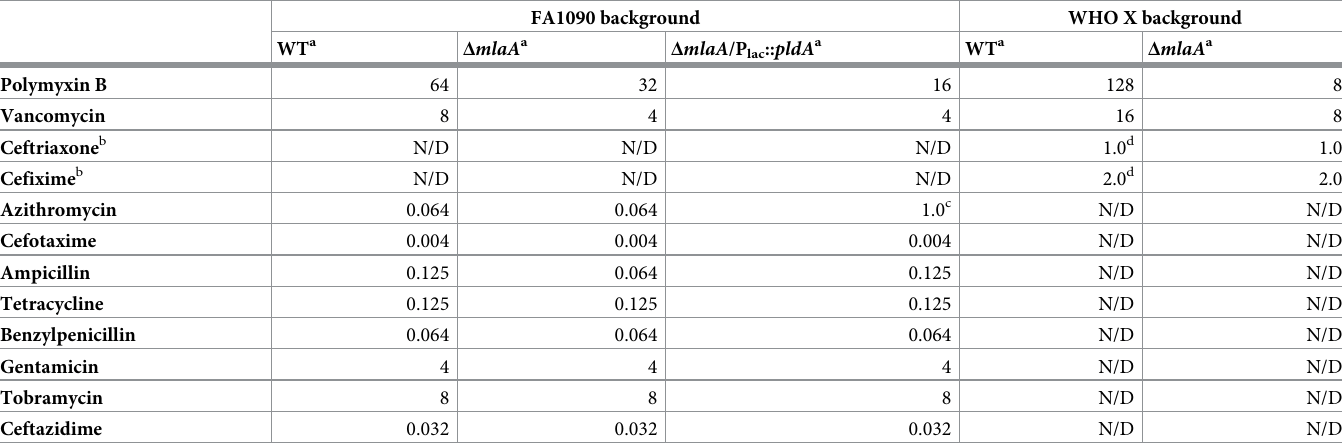
Table 2. Etest assessments of cell envelope